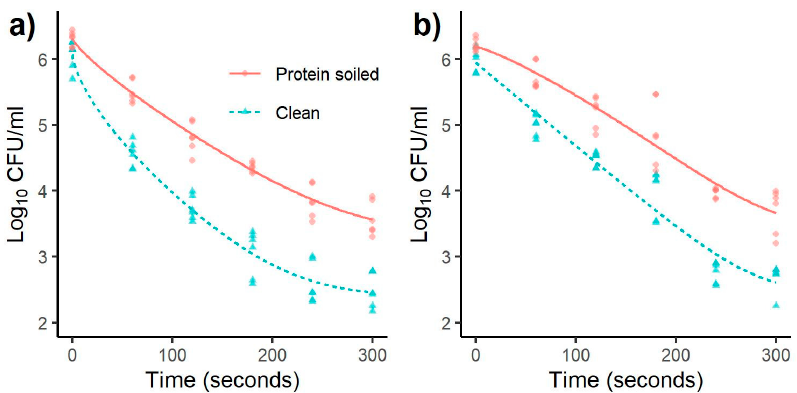
Figure 2. Effect of treatment time on inactivation of L. monocytogenes with a distance of ( a ) 10 and ( b ) 20 mm. Models were fitted using a Weibull + tail inactivation curve (Equation (2)) ( n = 6).